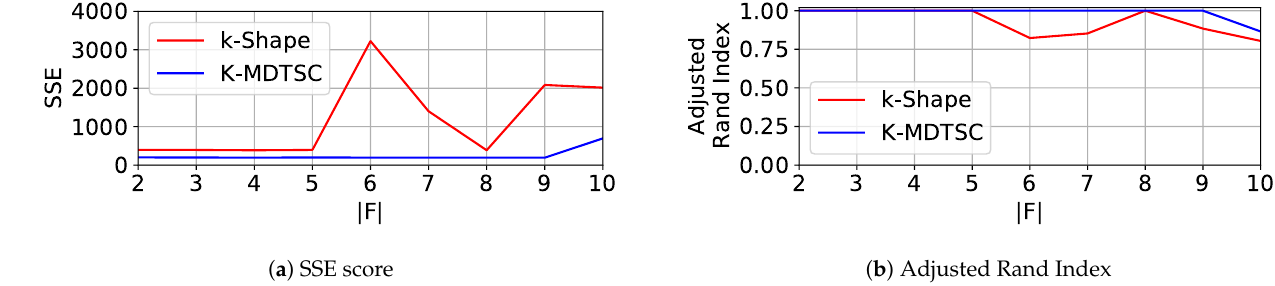
Figure 4. Number of families | F |